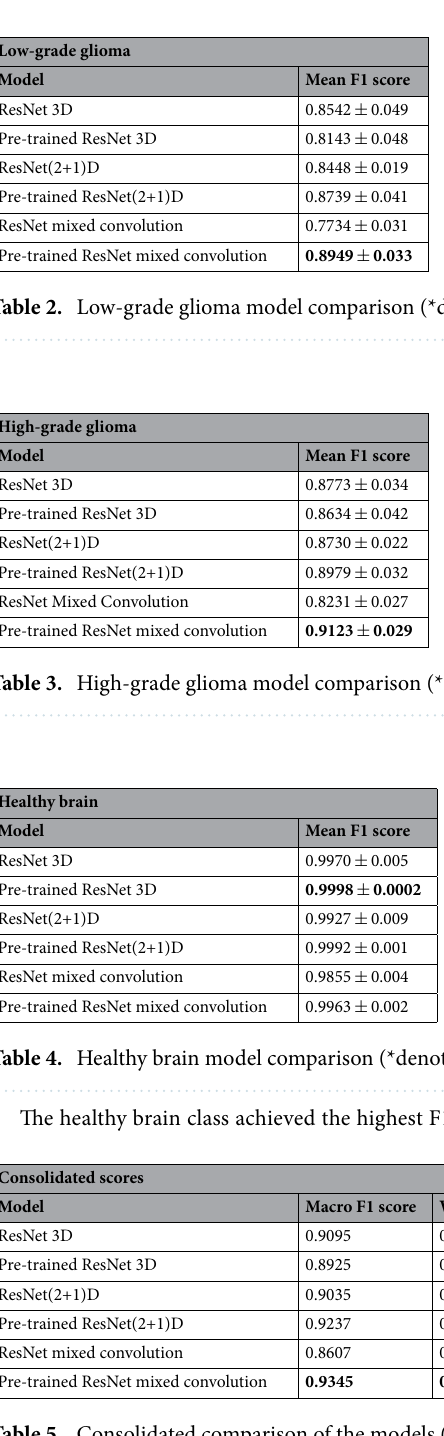
Table 5. Consolidated comparison of the models (*denotes the overall winning